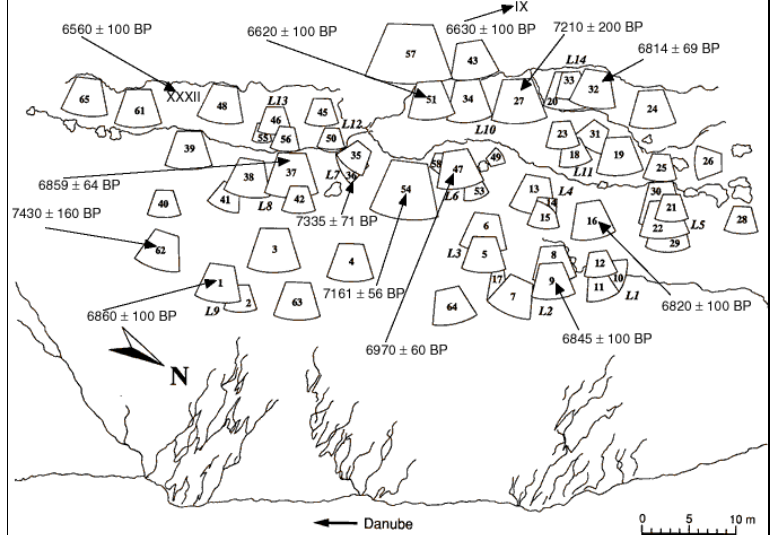
Figure 12. Arrangement of dwellings in Lepenski Vir I [19]